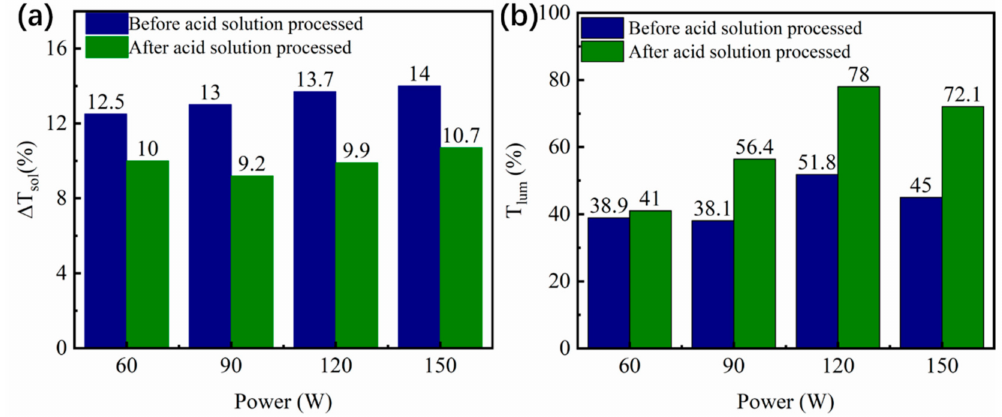
Figure 8. Comparison of ( a ) ∆ T sol and ( b ) T lum between Zn 2 V 2 O 7 -VO 2 composite films (before acid solution processing) and porous VO 2 films (after acid solution processing) with different sputtering power of ZnO